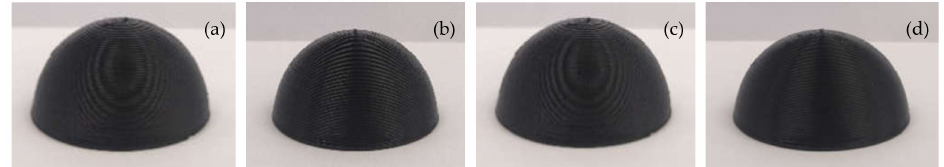
Figure 10. Finished parts of hemispherical model. ( a ) Finished part with slicing thickness of 0.4 mm. ( b ) Finished part with slicing thickness of 0.3 mm. ( c ) Finished part with slicing thickness of 0.2 mm. ( d ) Finished part manufactured by adaptive layering based on optimal volume error.